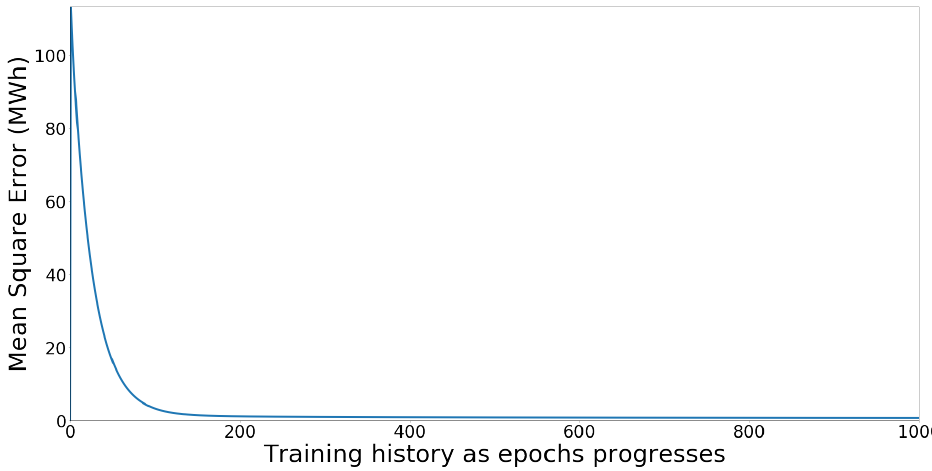
Figure 6. The mean square error as training